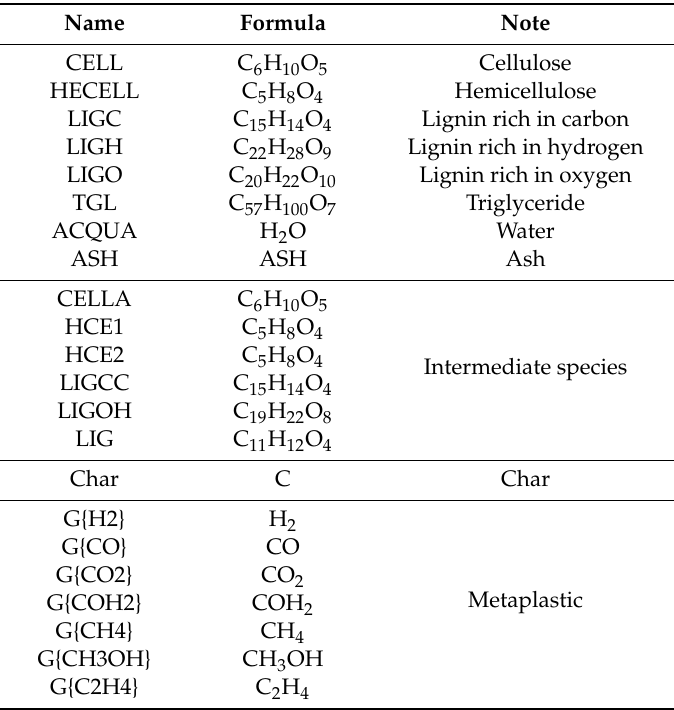
Table 4. Solid species in the simulation